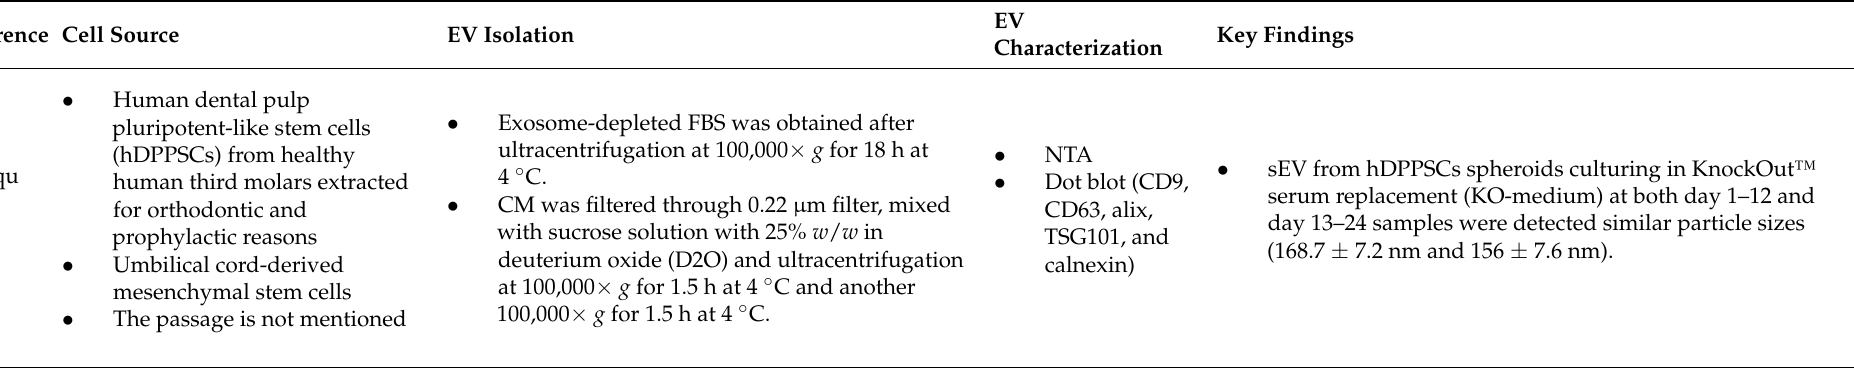
Table 4. The isolation, characterization, and function of